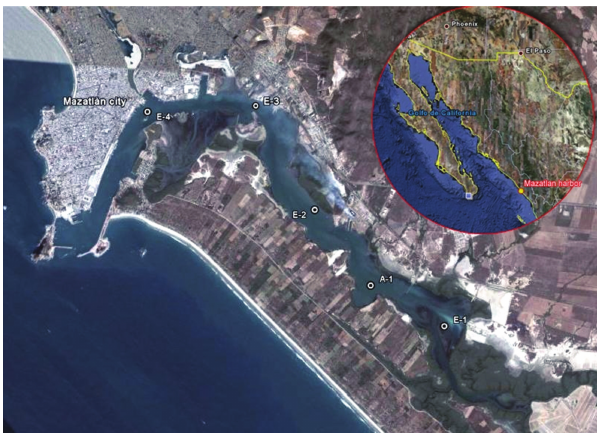
Figure 1: Estero de Urias estuary in Sinaloa,